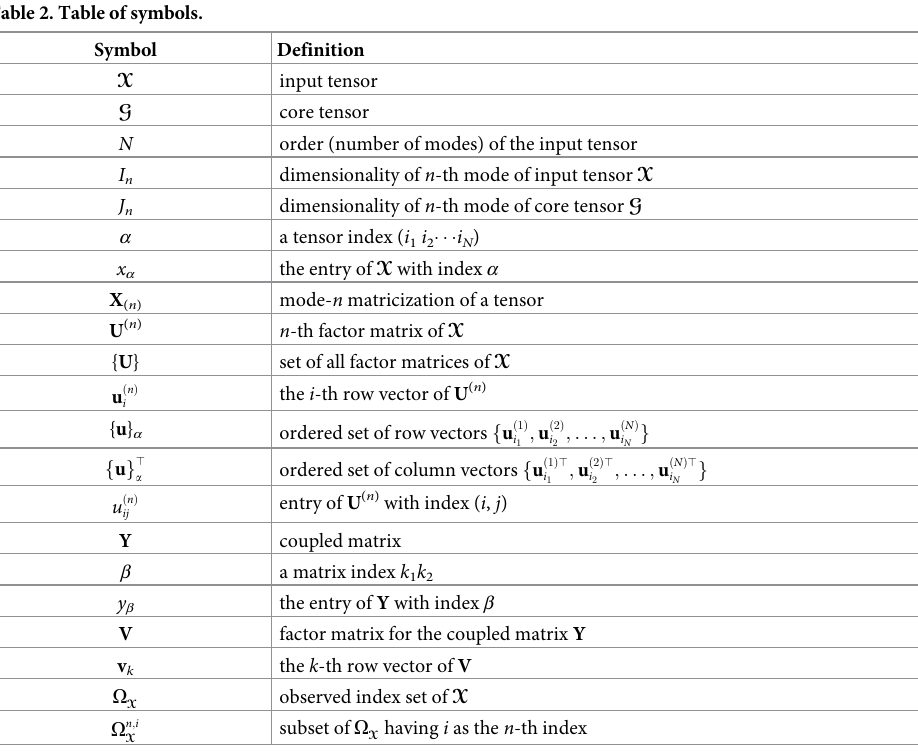
Table 2. Table of